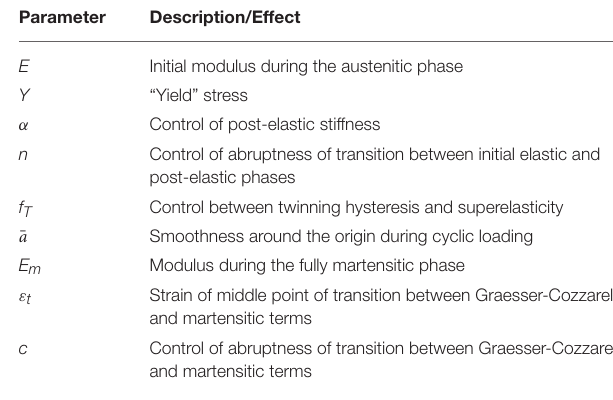
TABLE 1 | Brief description of proposed model parameters and their effect on the overall